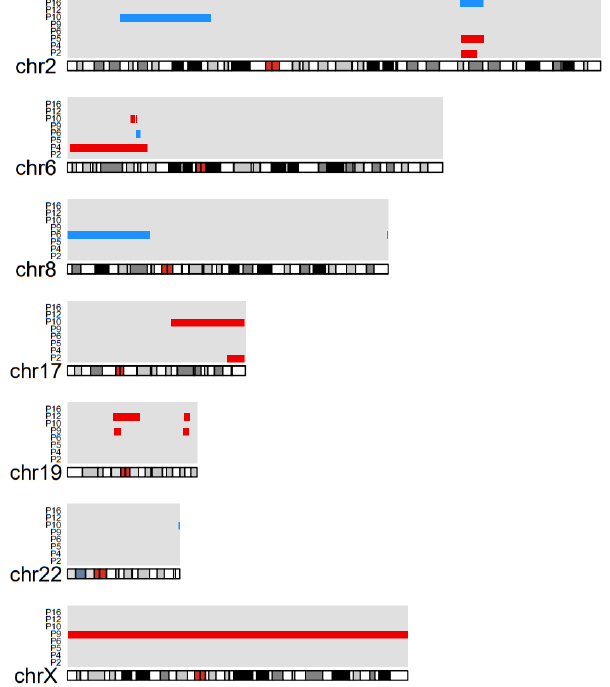
Figure 3. Copy number alterations detected in 8 out of 14 cases with primary Sjogren’s syndrome related extranodal marginal zone lymphoma of mucosa-associated lymphoid tissue. The vertical axis represents the cases with copy number alterations. The horizontal axis represents the location of the copy numbers detected in the displayed chromosomes. This figure shows a total of 18 copy number alterations, with a median of 2 copy number alterations (range 1–5) per case. (Blue: gain of copy number, red: loss of copy number).